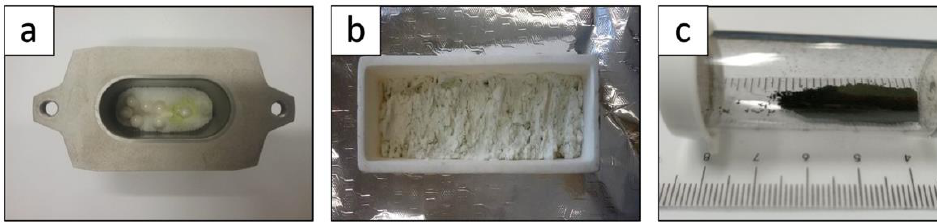
Figure 1. ( a ) Tungsten carbide container including sample mixture and ZrO 2 balls; ( b ) ball-milled